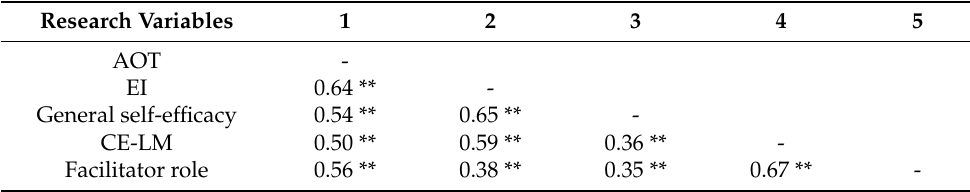
Table 2. Correlation matrix between research